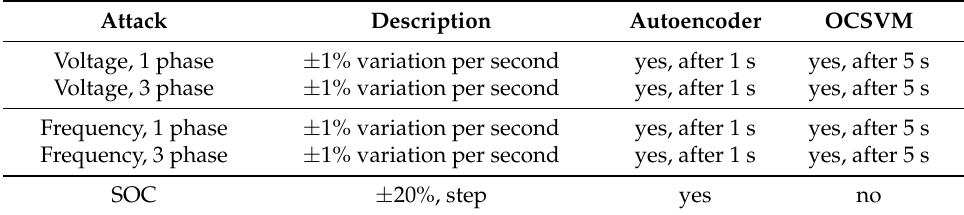
Table 5. Tests—Violating Safe Operating